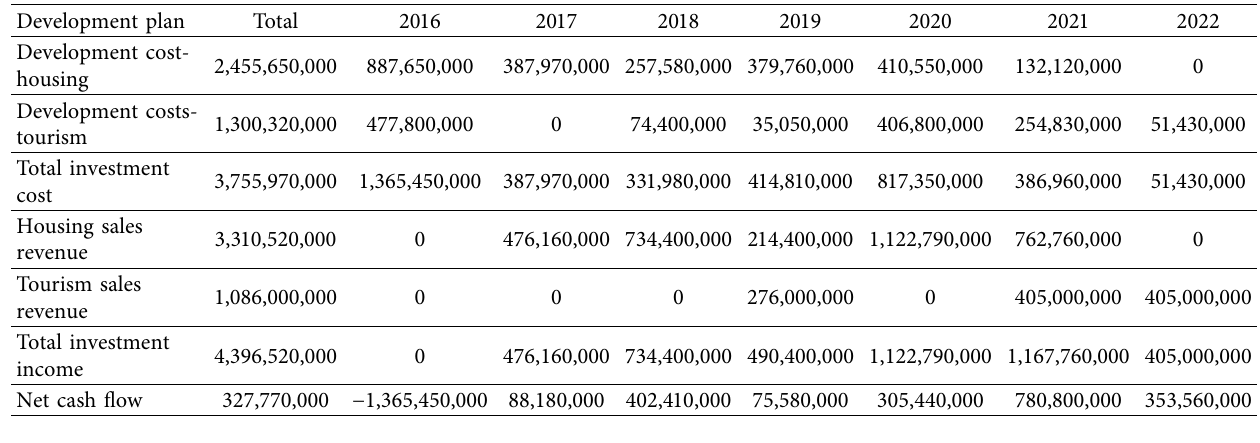
Table 3: Cash flow of the tourism real estate project under Project A (unit: yuan).